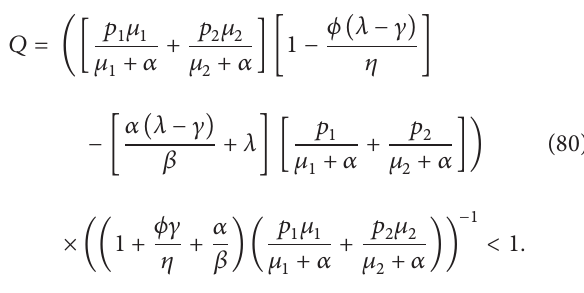
And the utilization factor